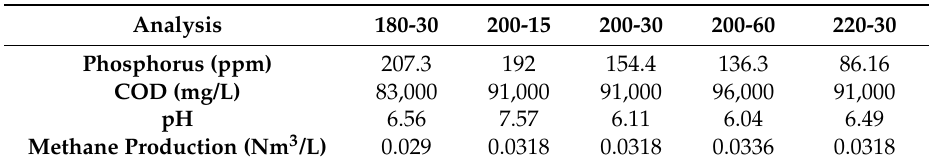
Figure 5. Nitrogen, phosphorus and potassium in hydrochar with carbon to nitrogen (C/N) ratio (dry basis). Table 3. Chemical Oxygen Demand and pH of process